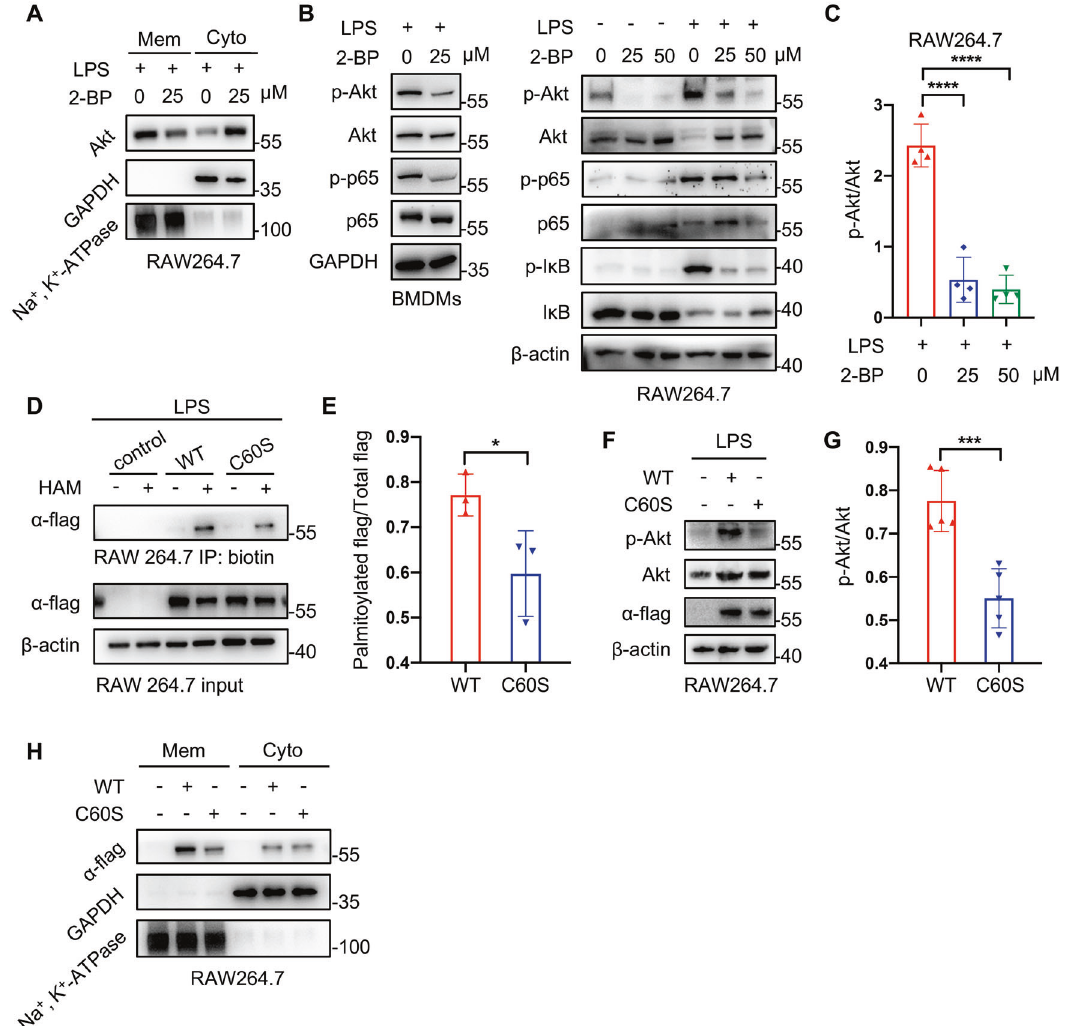
Fig. 6 The palmitoylation of Akt promoted its membrane distribution and phosphorylation (activation). A 2-bromopalmitate (2-BP, an inhibitor of palmitoylation) reduced the membrane localization of Akt in macrophages. B , C The activation of Akt was as well suppressed by 2-BP in macrophages. Representative images of western blotting ( B ) and quanti fi cation of a p-Akt/Akt ratio ( C ). D , E RAW 264.7 macrophages were transfected with fl ag-Akt plasmids to detect the palmitoylated site of Akt. The palmitoylated levels of mutant Akt (C60S) were lower than those of the wild type. Representative images of western blotting ( D ) and quantitative ratios of palmitoylated fl ag/total fl ag ( E ). F , G The mutant Akt (C60S) was less phosphorylated than the wild type. Representative images of western blotting ( F ) and quantitative ratios of p-Akt/ Akt ( G ). H The mutant Akt (C60S) was less recruited to membrane than the wild type. Data were represented as means ± SD. * p < 0.05, ** p < 0.01, *** p < 0.001, **** p < 0.0001, ANOVA or t